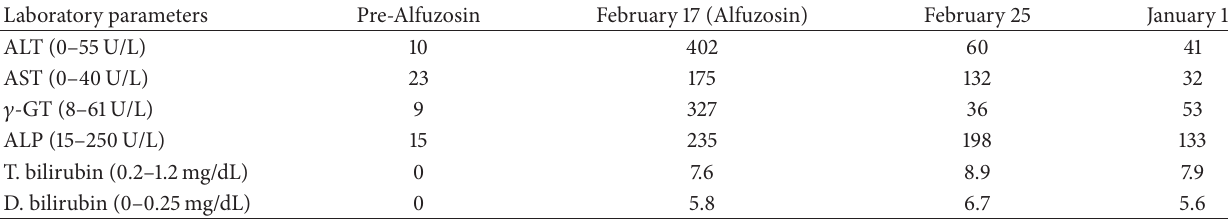
Table 1: Laboratory